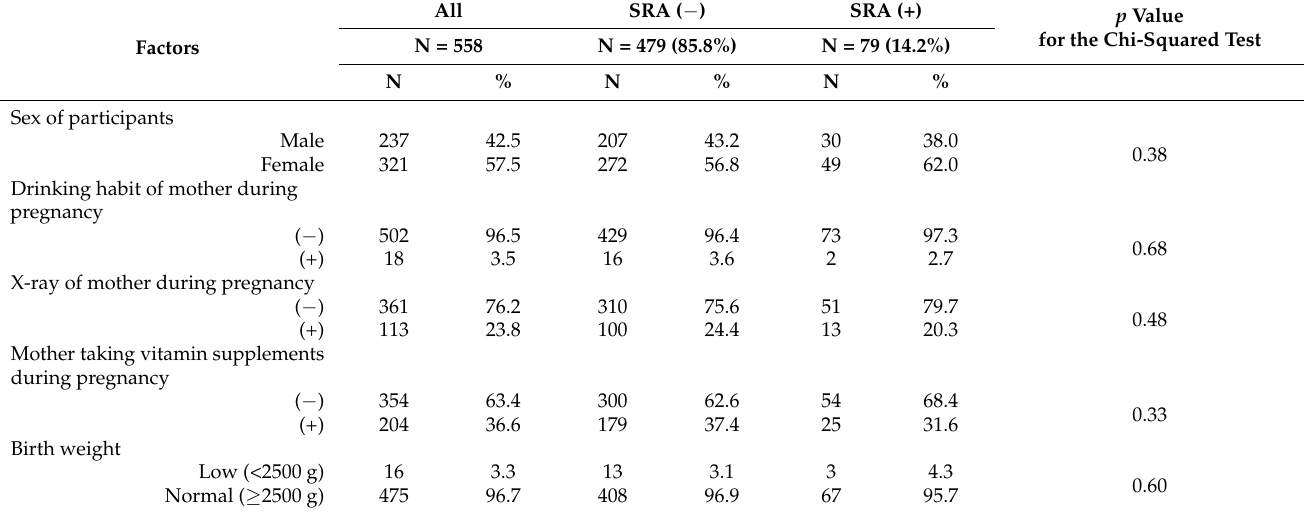
Table 2. Socio-demographic characteristics of participants based on the presence of